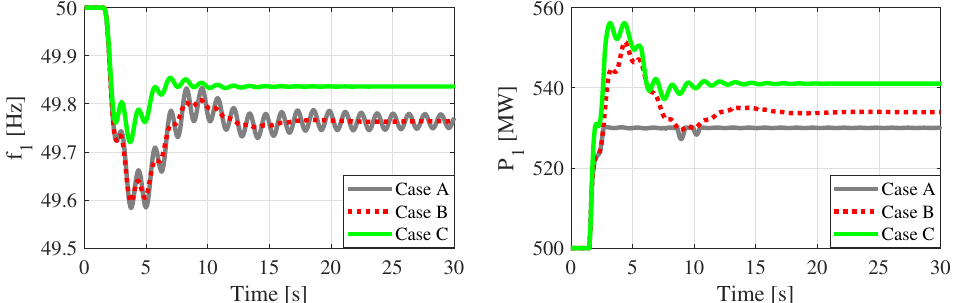
Figure 8. Onshore frequency, f 1 , and power fed by VSC1, P 1 , when using CFC from offshore HVDC.